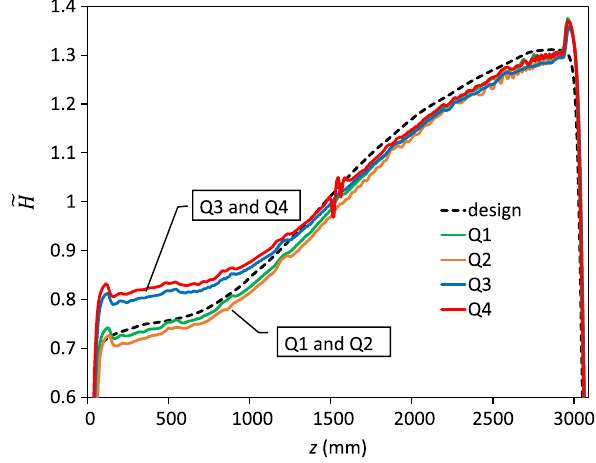
FIG. 13. Measured H profile for all the quadrants before tuning. The dashed line is the design profile obtained in Sec.